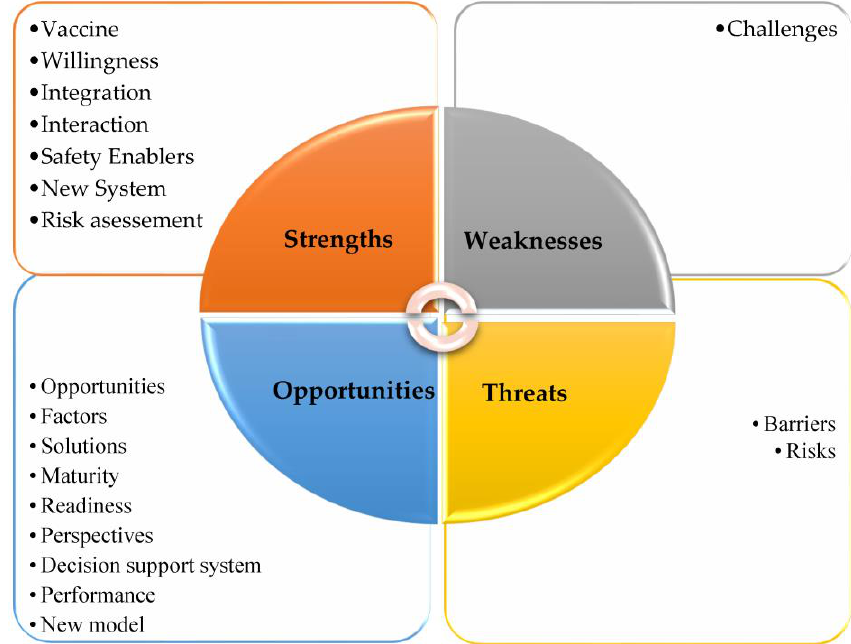
Figure 3. Themes and subthemes for the existing research on Construction 4.0 technologies and de-